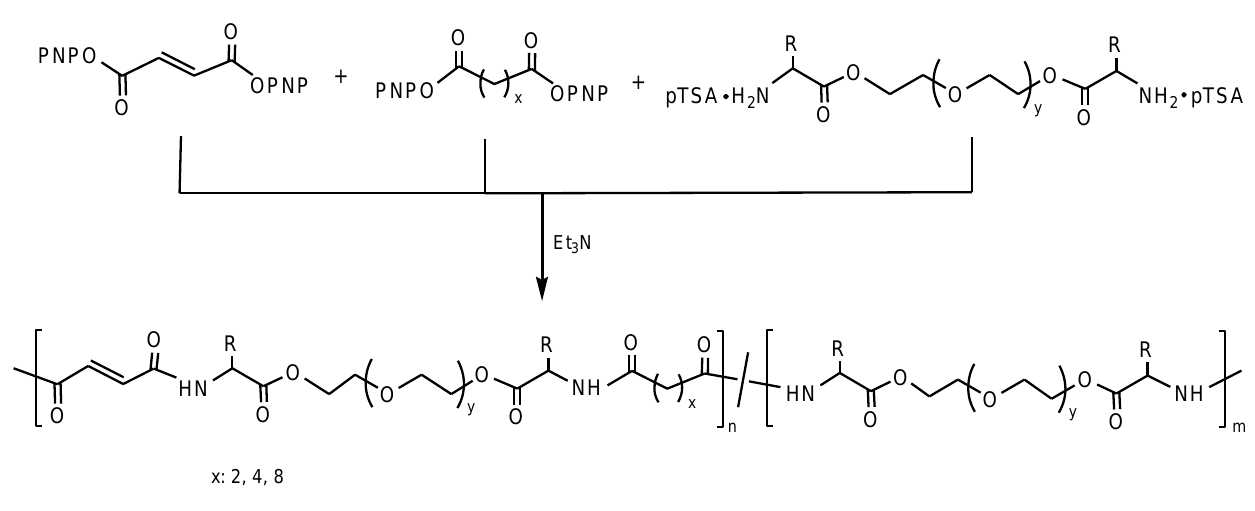
Figure 14. Synthesis of poly(ether ester amide)s constituted by saturated and unsaturated dicarboxylic acid